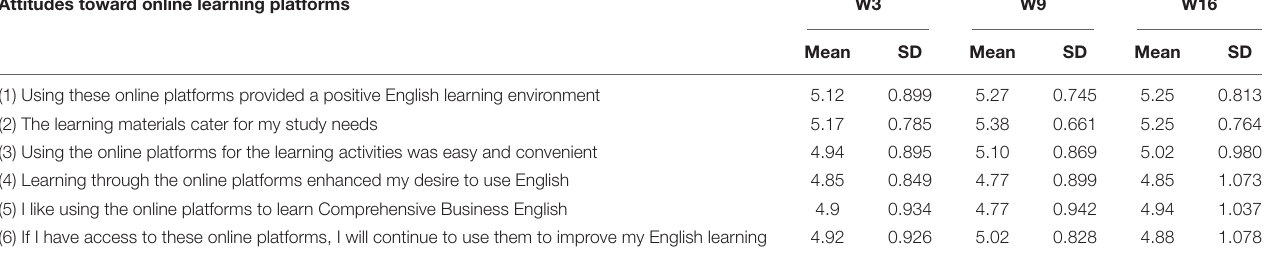
TABLE 4 | Average scores of students’ technology acceptance. Attitudes toward online learning